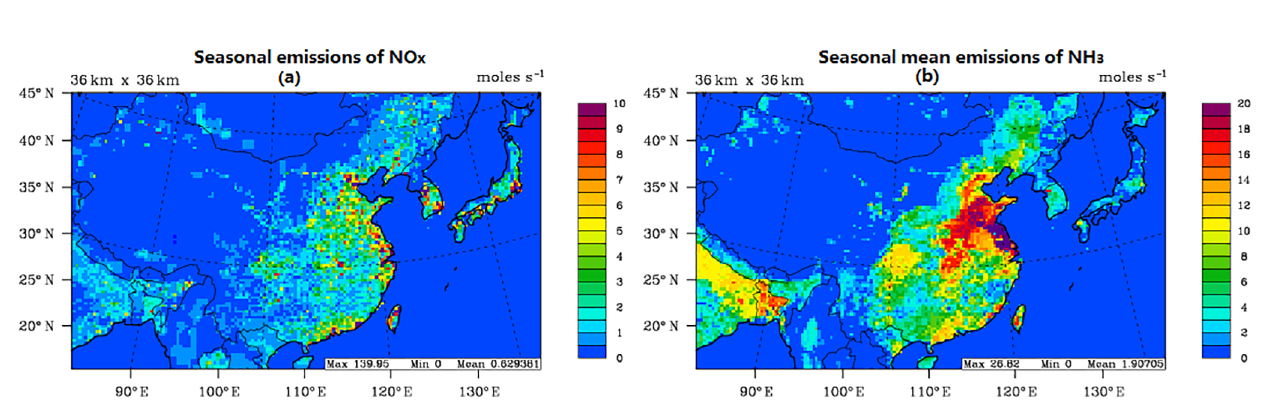
Figure 6. Seasonal mean emissions of NO x (a) and NH 3 (b) over East Asia during March–May